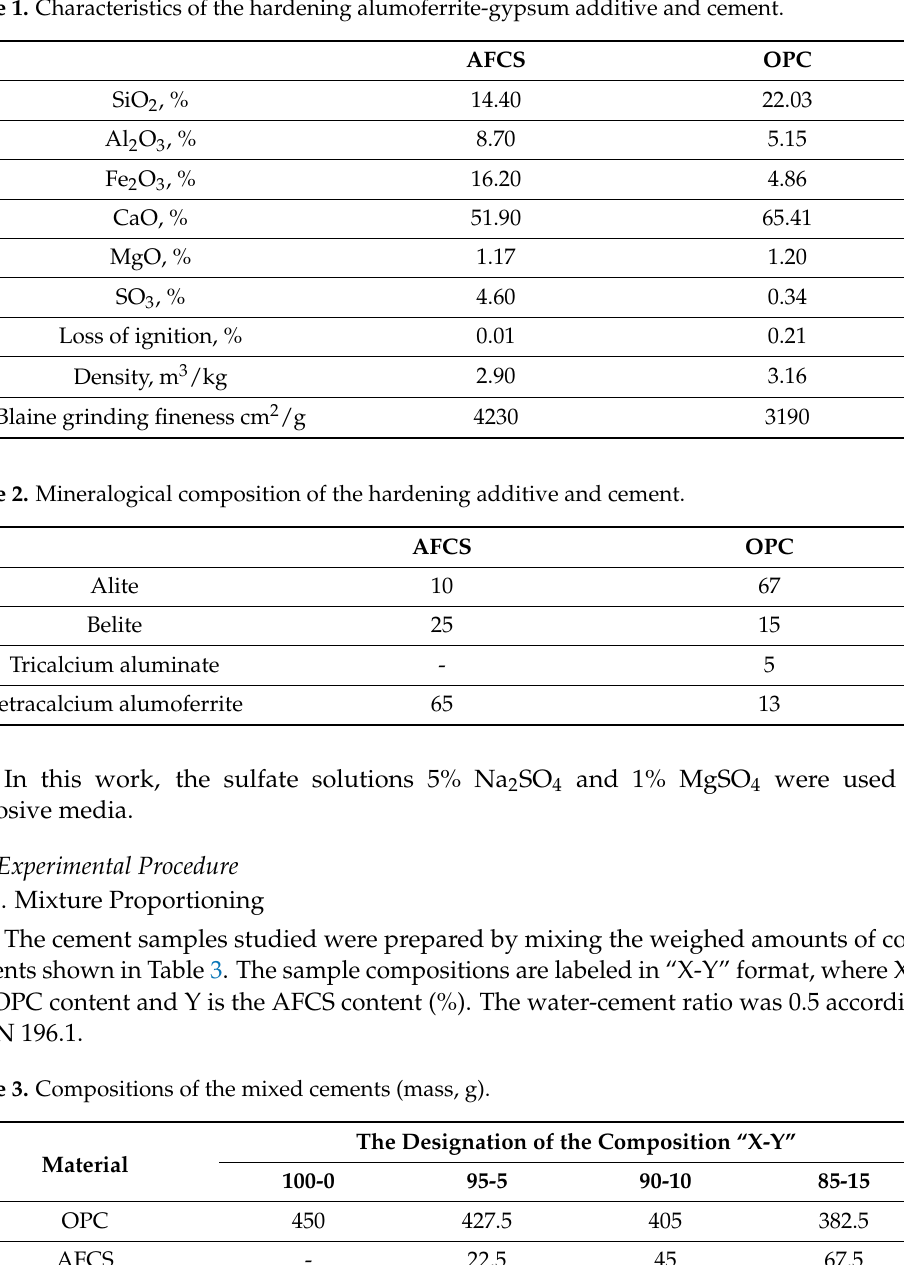
Table 1. Characteristics of the hardening alumoferrite-gypsum additive and cement.